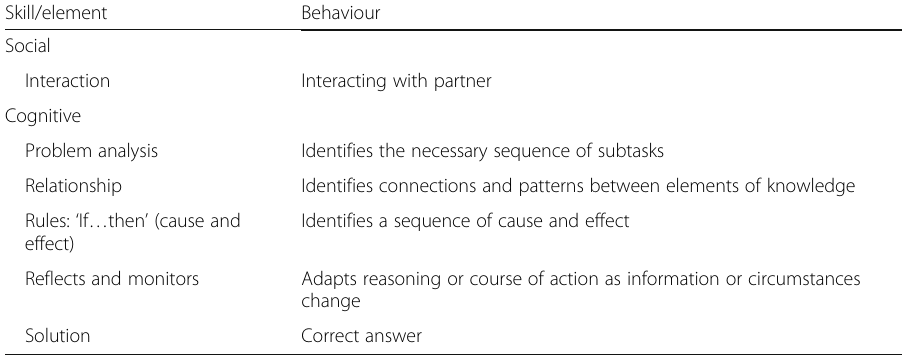
Table 6 The categorisation matrix of the behavioural indicators of CPS elements in the Olive